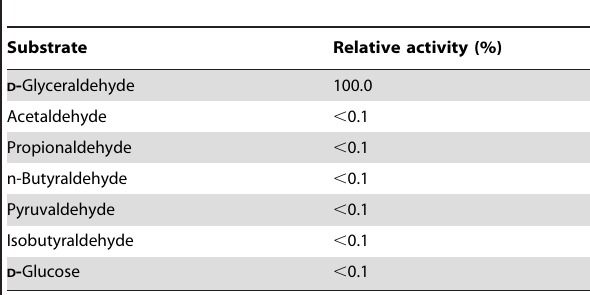
Table 6. Substrate specificity of refolded Ta AlDH at 50 u C, pH